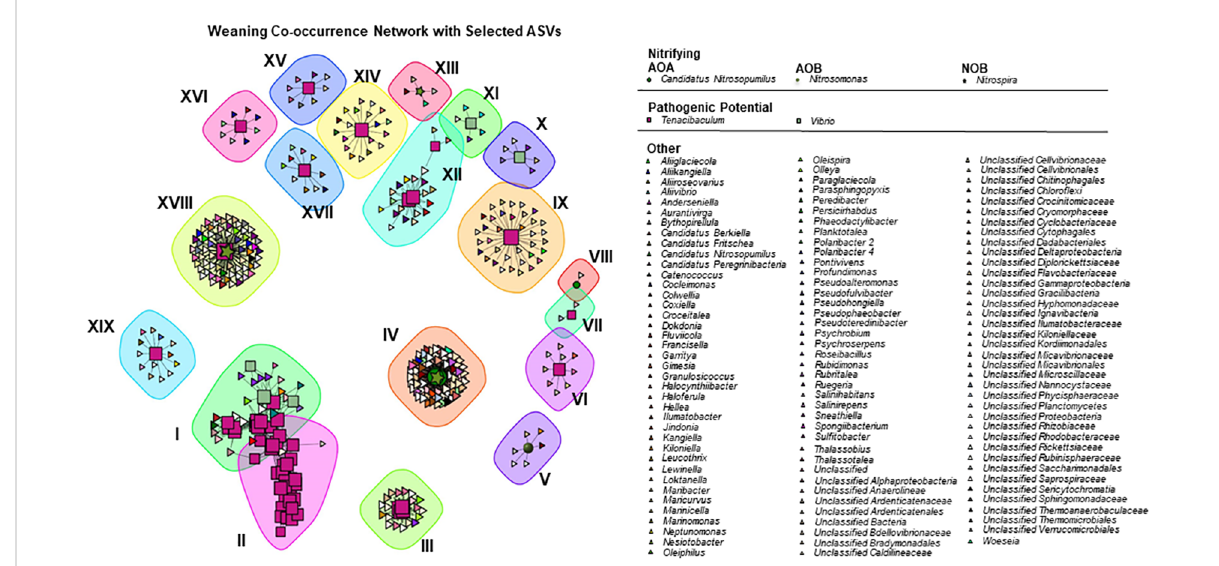
FIGURE 4 Correlations network in weaning samples, coloured by Genus and shapes by function: pathogenic (squares), nitrifying oxidizing bacteria (stars), ammonia oxidizing bacteria (circles), ammonia oxidizing archaea (spheres) and other